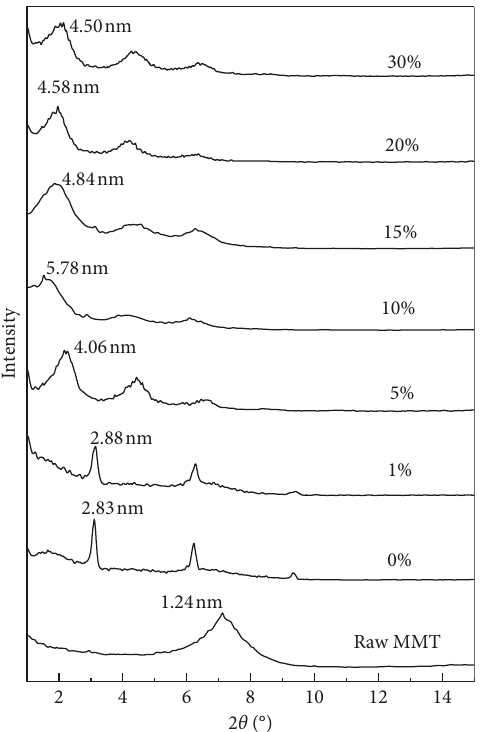
Figure 1: X-ray diffraction patterns of MMT and C